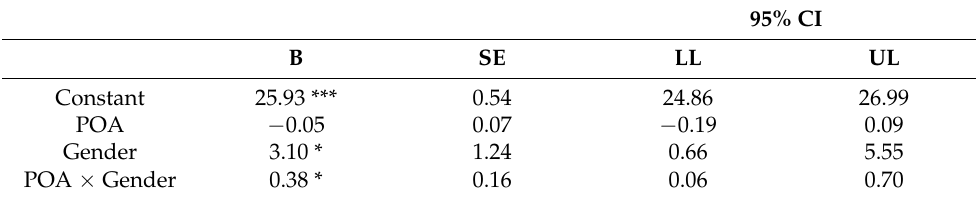
Table 14. Unstandardized coefficients for Model 4.